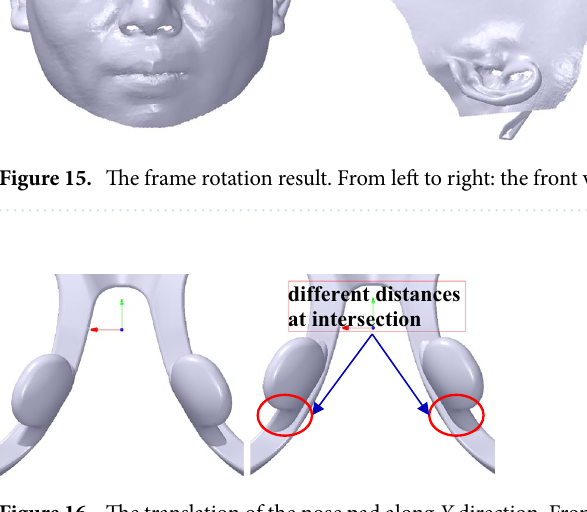
Figure 16. The translation of the nose pad along Y direction. From left to right: origin nose pad, translation.